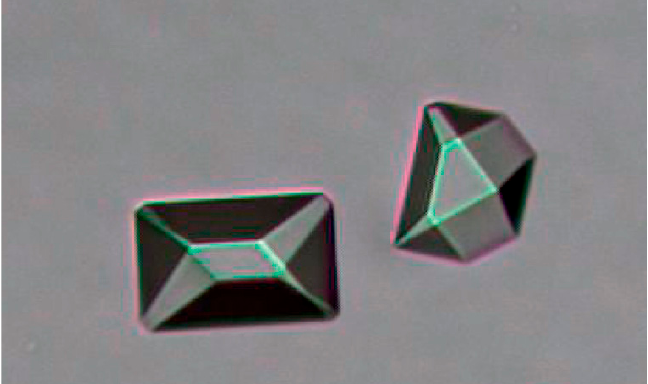
Figure 2. Crystal photo of the Te-DNA octamer [5 ′ -G(2 ′ -SeMe-dU)G( Te T)ACAC-3] 2.